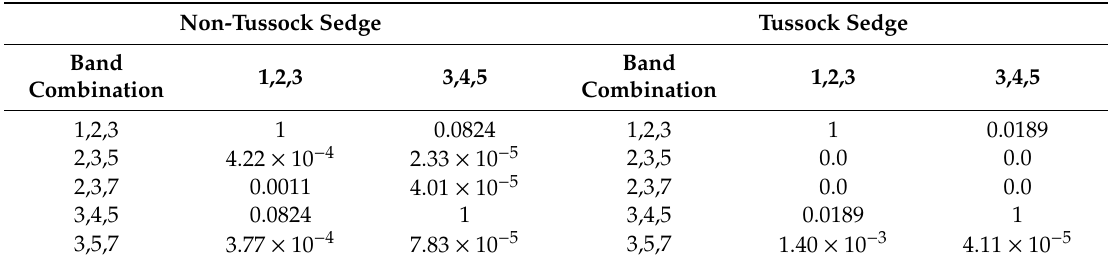
Table 4. p -values of the Kruskal–Wallis test for F1 scores.